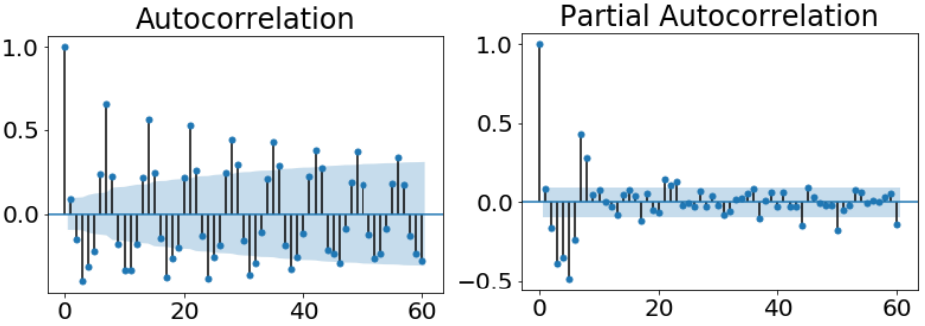
Figure 3. ACF and PACF for daily confirmed cases with 60 lags: